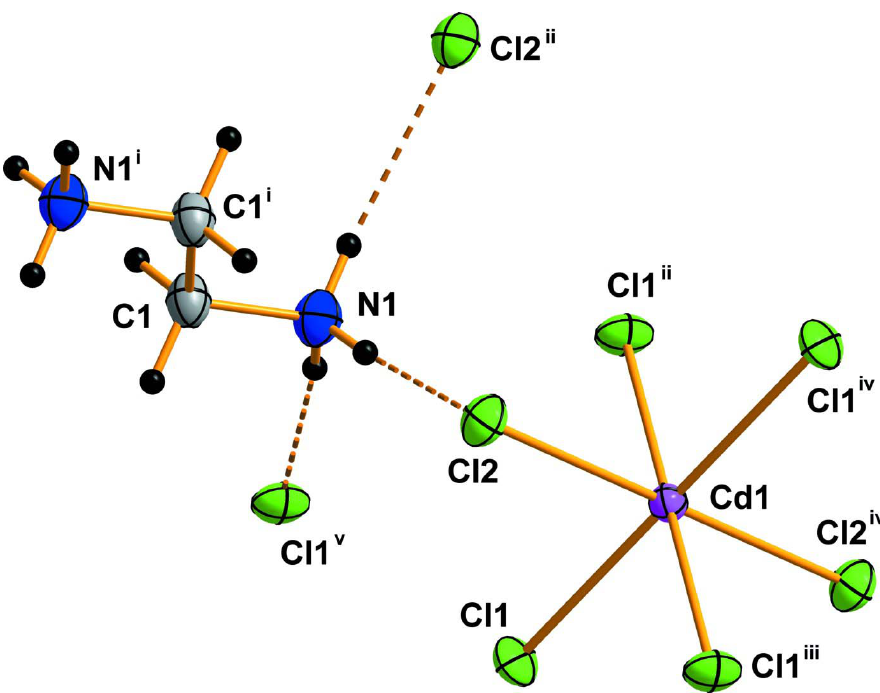
CH CH NH )[CdCl ]. Displacement ellipsoids are drawn at the 50% probability level. 3 2 2 3 4